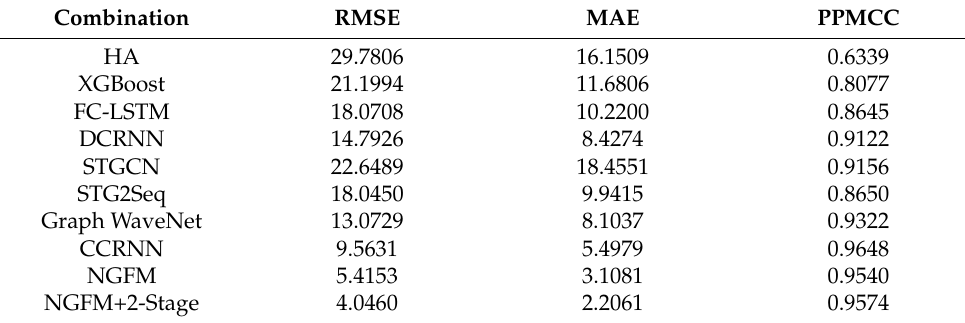
Table 4. The comparative experiment